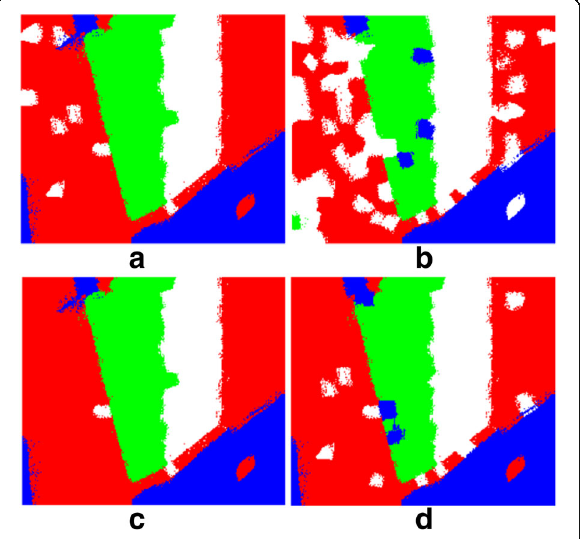
Fig. 9 The classification result of the PolSAR image by different dimension reduction methods. a PCA + SVM + superpixels. b LDA + SVM + superpixels. c LE + SVM + superpixels. d MVU + SVM + superpixels